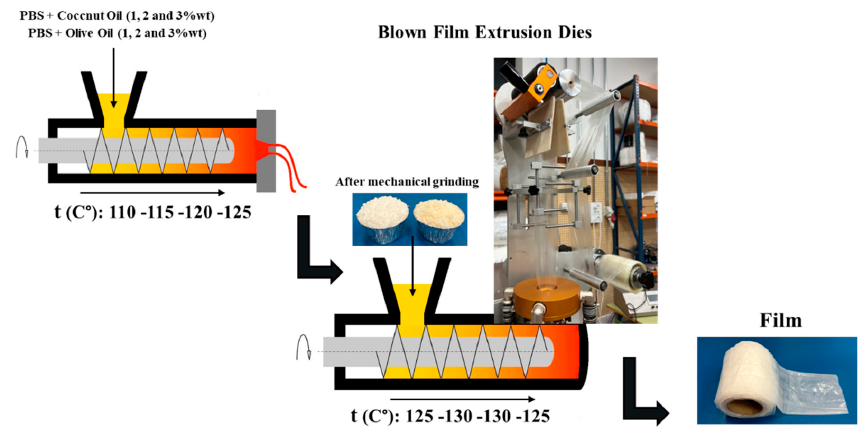
Figure 1. Flowchart for obtaining the film.